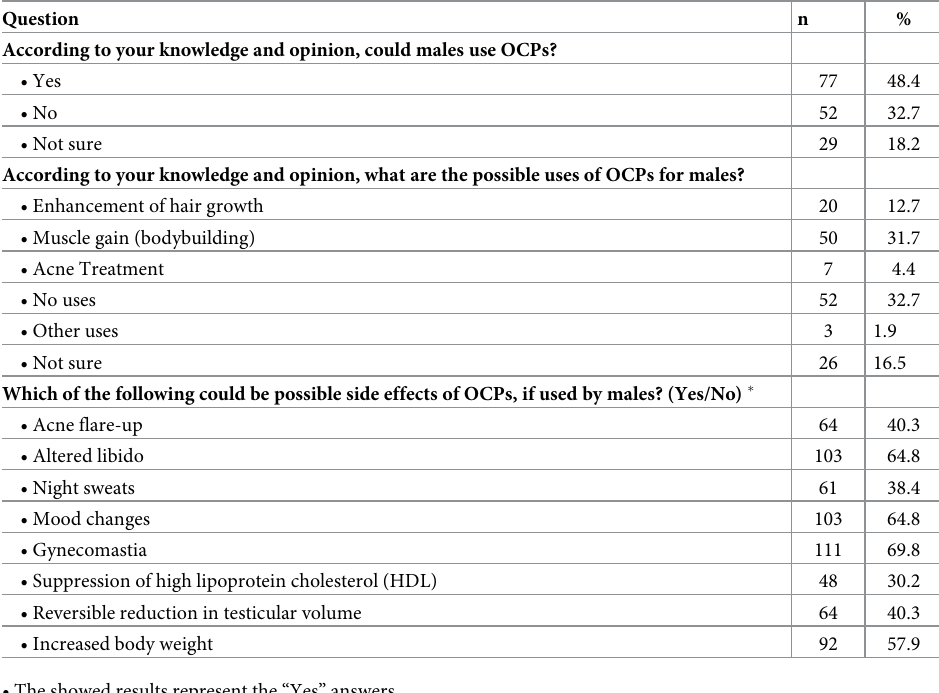
asking for OCPs containing estrogen (Ethinyl estradiol) and progestins (Drospirenone or